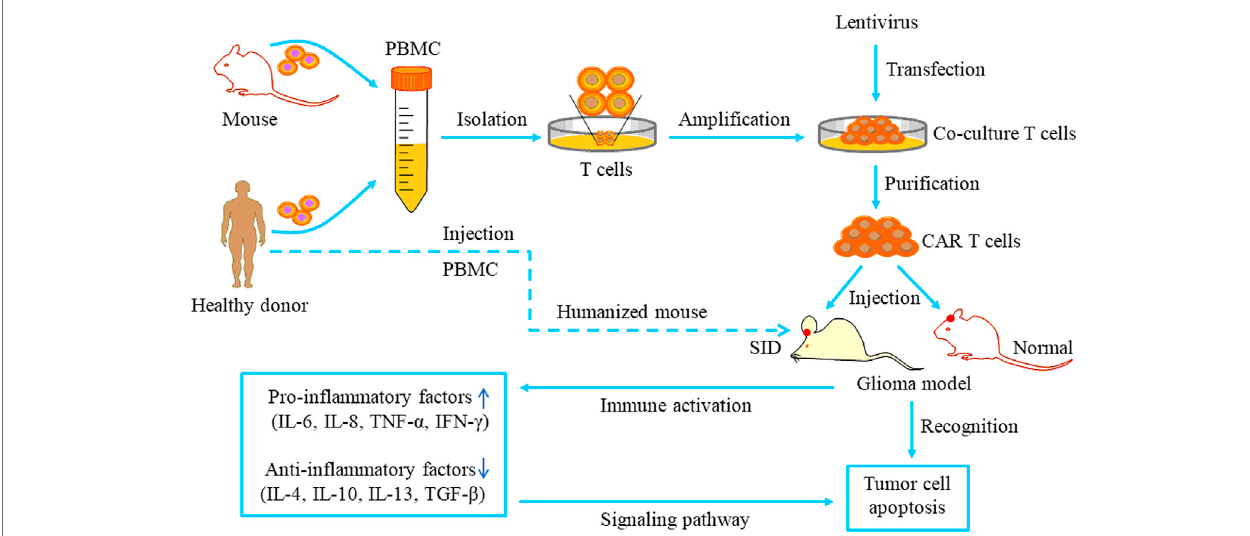
FIGURE 4 | The pattern of CAR T cell-based therapy studies for glioma. T cells are separated from the peripheral blood of healthy donors or mice and cultured in specialmedia.Thelentiviruscarryingaspeci fi cligandistransducedintotheculturedTcells.Thenthepuri fi edCARTcellsareinjected intoorthotopicgliomamodelsand recognize tumor cells via speci fi c binding to antigen receptors. Immune system activation can increase pro-in fl ammatory events and reduce anti-in fl ammatory events, ultimately inducing tumor cell apoptosis via speci fi c signaling pathways.